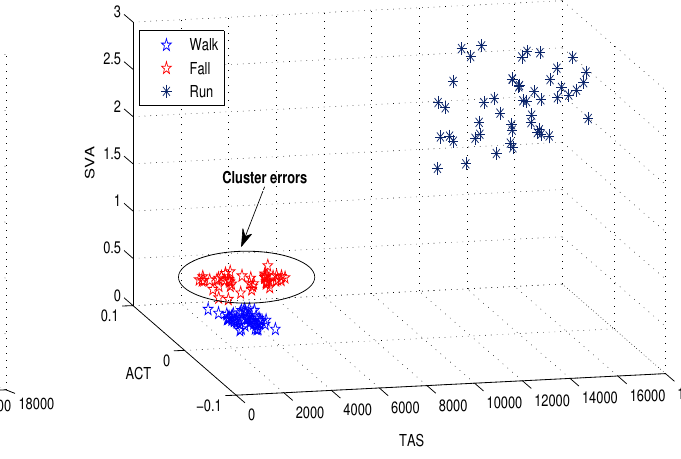
Figure 7. Unforeseen motion detection results by proposed ( left ) and FCM clustering algorithm ( right